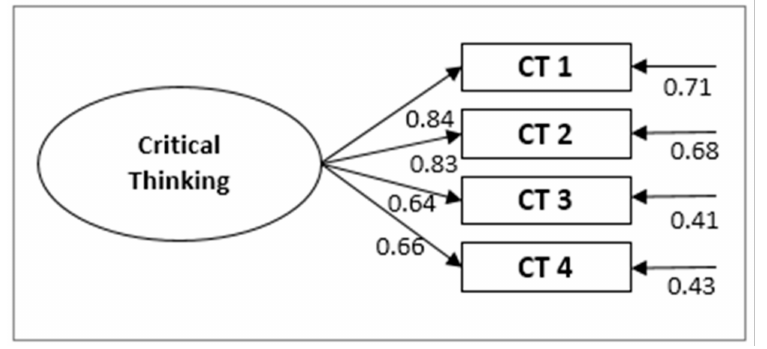
Figure 3. Measurement model for critical thinking ( c